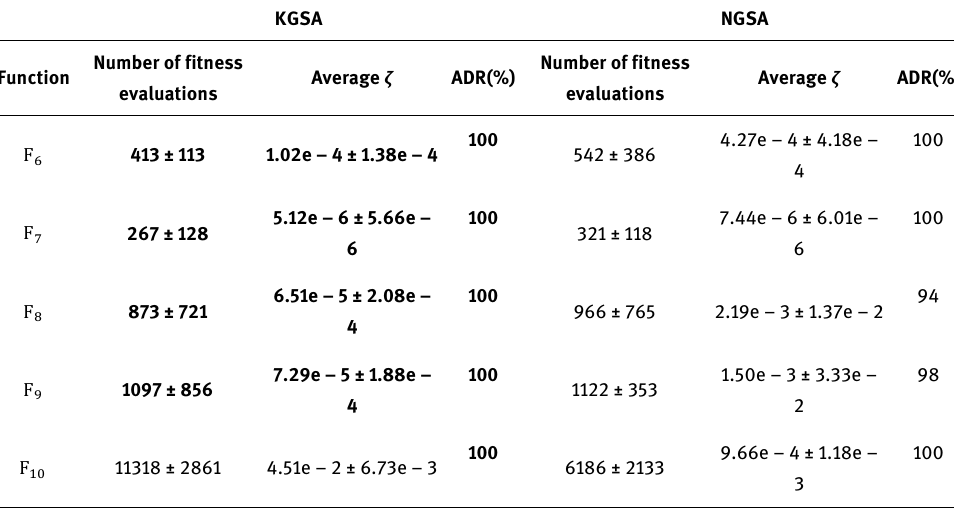
Table 8: Results of KGSA and NGSA in terms of %ADR and the number of fitness assessments needed to converge for each niching algorithm using functions F 6 to F 10 . The results were averaged after fifty independent runs of algorithms.